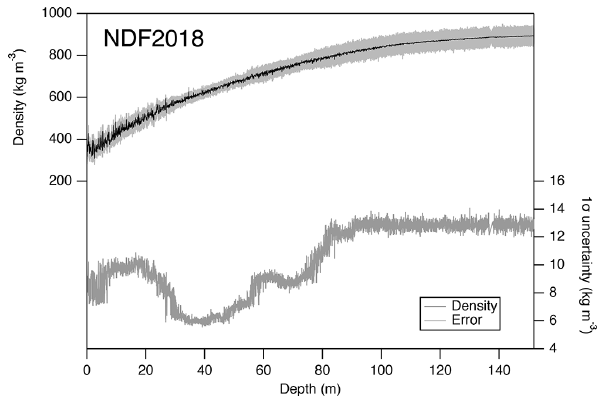
Figure A2. Example of density uncertainty (NDF2018